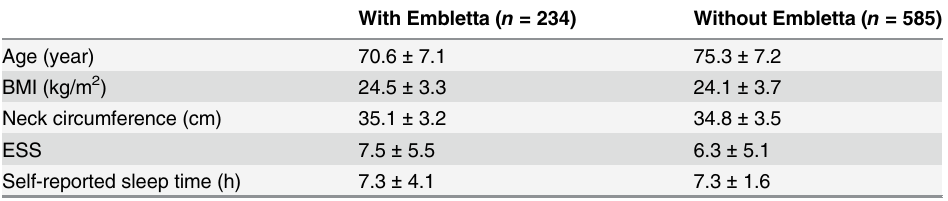
Table 3. Baseline characteristics of subjects with and without Embletta home sleep study (mean ± SD).